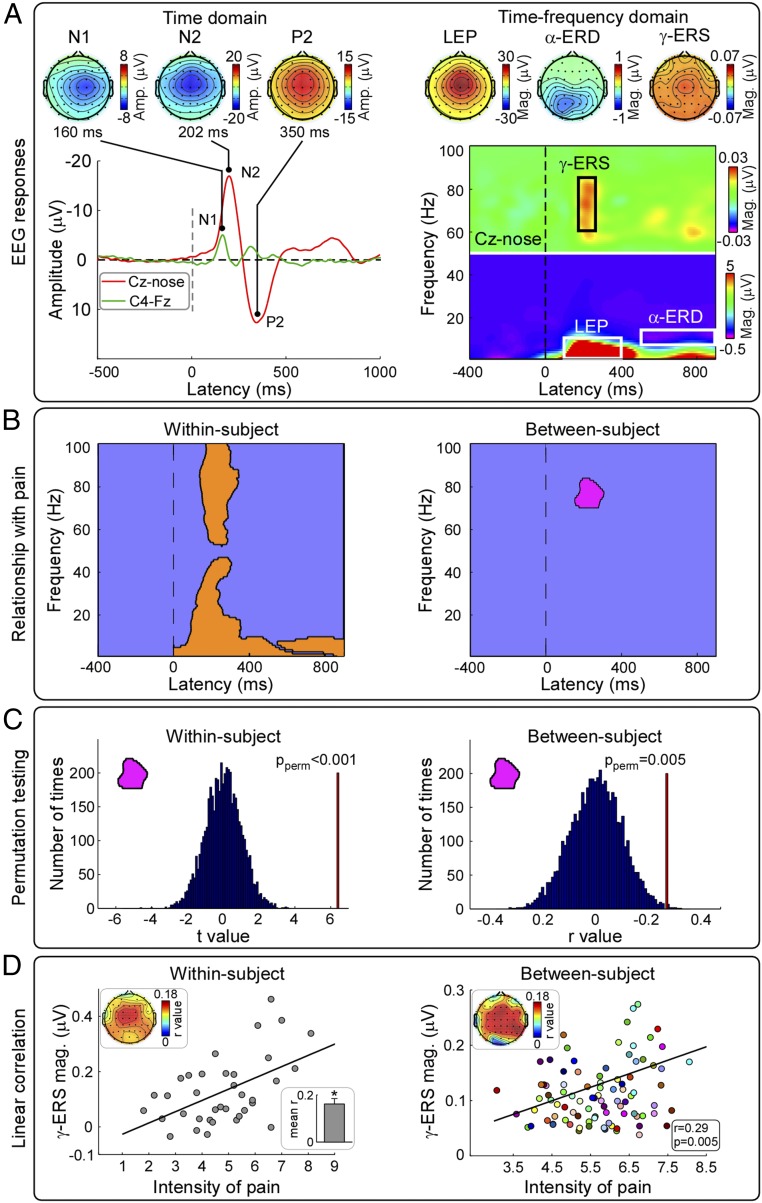
Experiment 1. EEG indicators of within-subject and between-subject variability of pain perception in humans. (A, Left) Group-level LEP waveform and scalp topographies of N1, N2, and P2 waves. (A, Right) Group level TFDs and scalp topographies of LEP, α-ERD, and γ-ERS features. (B) Time-frequency clusters reflecting within-subject and between-subject variability in pain ratings are represented in orange and purple respectively. (C) The ability of the γ-ERS cluster (152 to 294 ms, 70 to 88 Hz) to reflect within-subject variability in pain ratings (t-value, vertical red line in the left plot) and between-subject variability in pain ratings (r-value, vertical red line in the right plot) was always significantly different from chance (P < 0.001 and P = 0.005 respectively; 5,000 permutations). (D) At both within-subject and between-subject levels, there was a significant linear correlation between γ-ERS magnitude and subjective reports of pain intensity (within-subject, r = 0.16 ± 0.23, P < 0.001, one-sample t test; between-subject, r = 0.29, P = 0.005). Note that the between-subject correlation result obtained defining the TF-ROI in a data-driven fashion using permutation testing (r = 0.29, P = 0.005) is slightly different from that obtained defining the TF-ROI on the basis of previous publications (r = 0.24, P = 0.01) (Table 1). These correlations were maximal over fronto-central regions. At within-subject level, each dot represents a single trial (data from a representative subject). At between-subject level, each dot represents a subject. Black lines represent the best linear fit. Amp., amplitude; Mag., magnitude; Pperm, P value for permutation test.